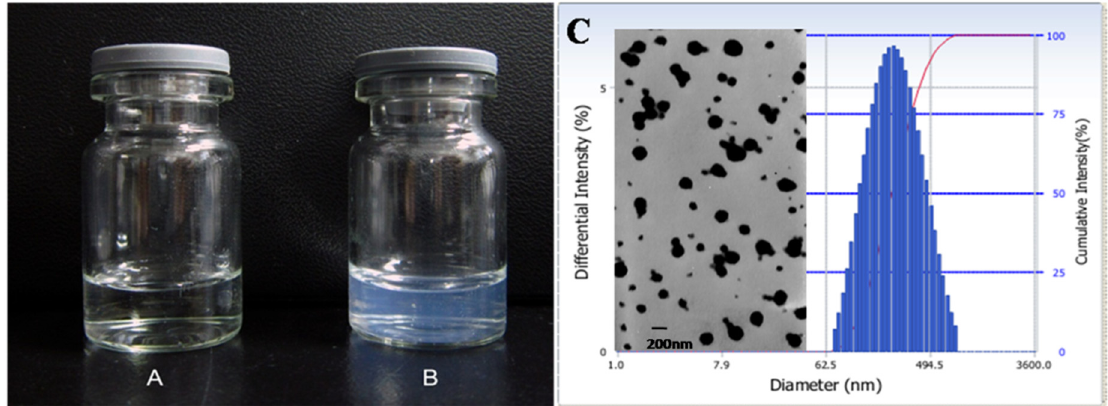
Figure 4. Appearance of CS-DTPA-Gd ( A ) and GCHN ( B ), TEM image and particle size distribution of GCHN ( C